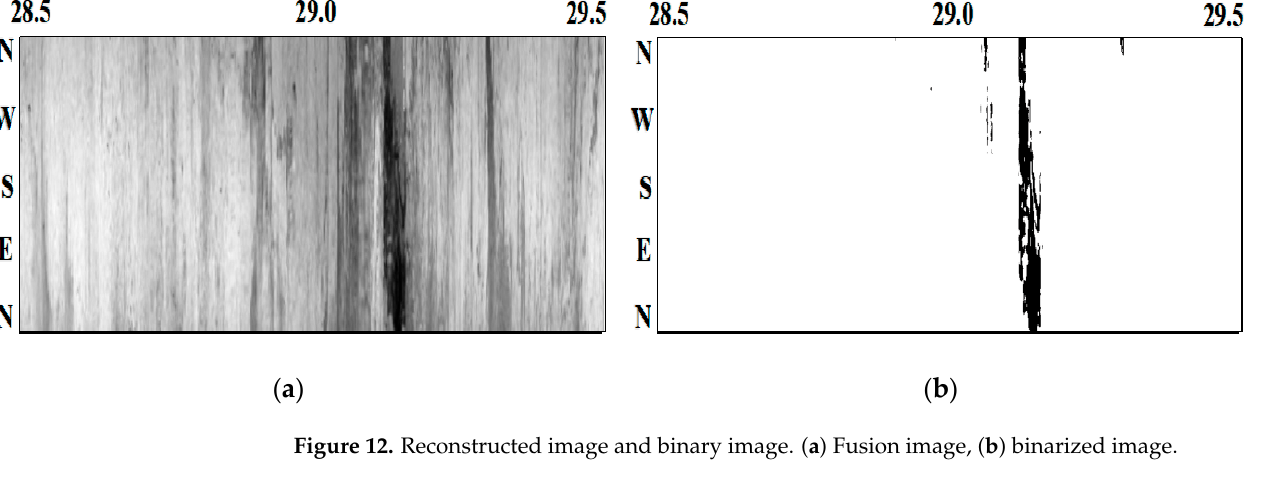
Figure 13. Image comparison before and after well wall fusion. ( a ) Optical image ( b ) processed image.